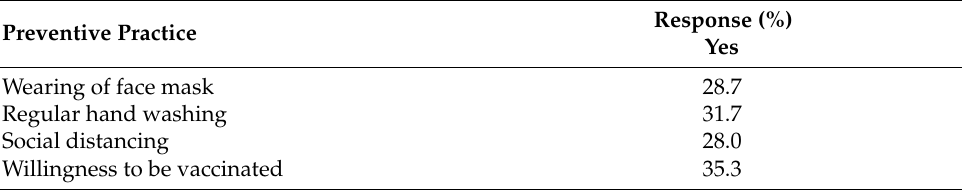
Table 2. Responses to the different preventive practices/measures presented as average weighted mean numbers.